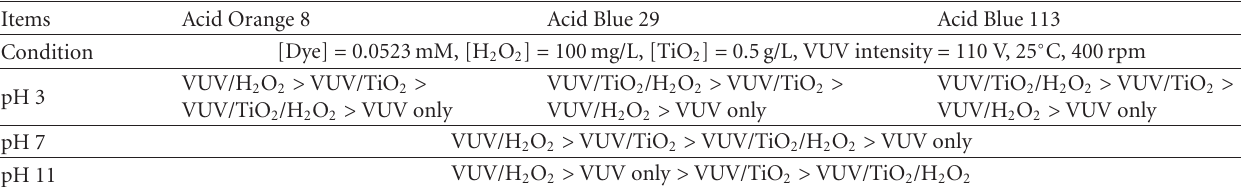
Table 4: Summarized result for comparison among treatment e ffi ciencies of dyes by various AOPs.